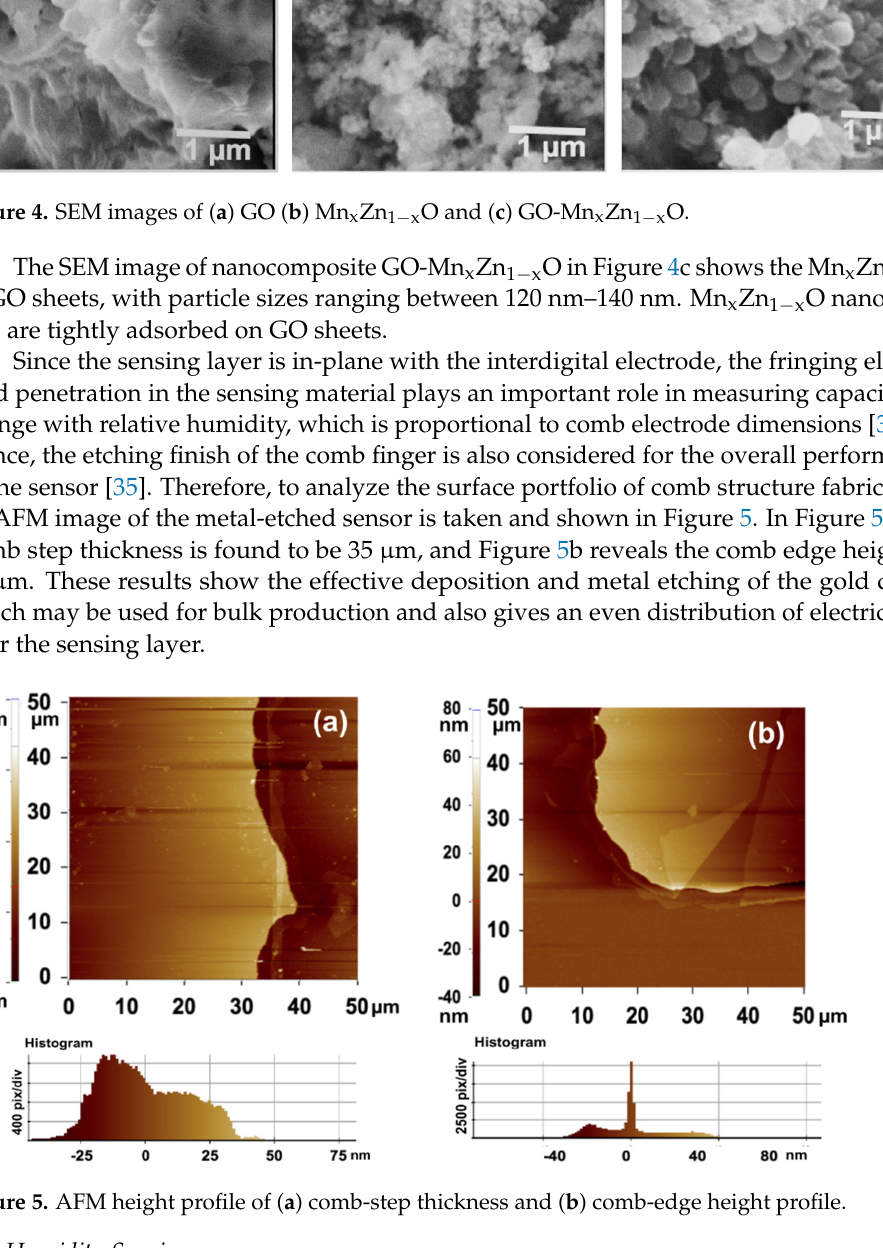
Figure 5. AFM height profile of ( a ) comb-step thickness and ( b ) comb-edge height profile.